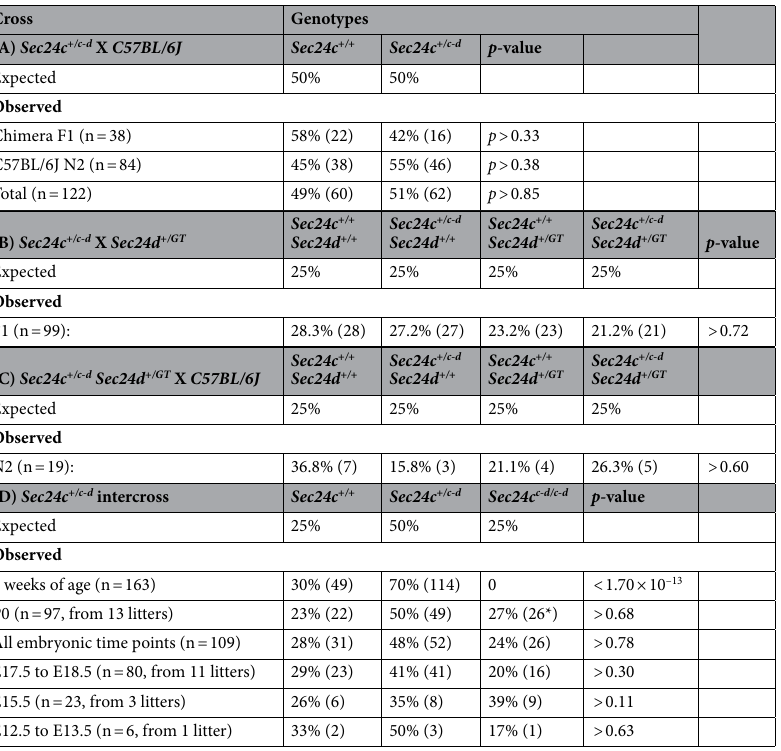
Table 1. Results of Sec24c + /c-d backcrosses and intercrosses. Distribution of progeny from (A) Sec24c + /c-d backcrosses (B) Sec24c + /c-d x Sec24d + /GT intercrosses, (C) Sec24c + /c-d Sec24d + /GT backcrosses and (D) Sec24c + /c-d intercrosses. Genotypes shown for chimera F1 only include those of chimera/ B6(Cg)-Tyr c-2J /J F1 progeny with black coat color. All Sec24d + /GT mice used in this study were ≥ N18 on C57BL/6J background. For intercross data , p- values are calculated based on “others vs. rescue” genotypes (0.75:0.25). *all Sec24c c-d/c-d mice were dead at P0. The E15.5 time point in (D) contains genotypes for a single Sec24c + /c-d resorbed embryo and two Sec24c c-d/c-d resorbed embryos. All observed numbers are listed in